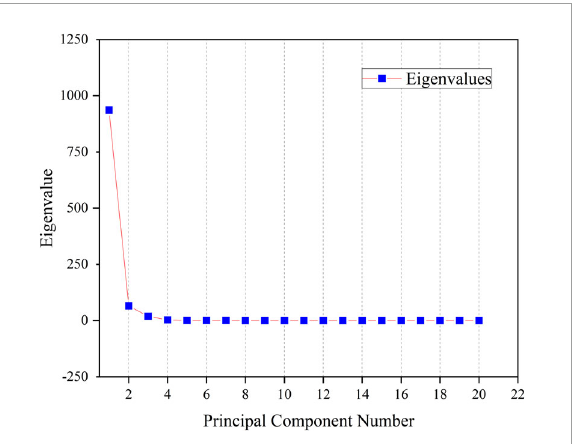
FIGURE8 Relationship between the contribution of sample information and individual components.